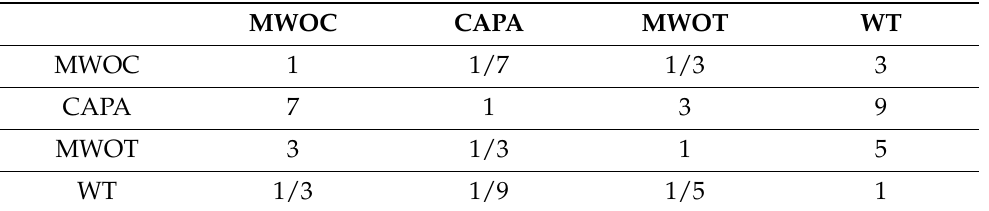
Table 7. Prioritization criteria pairwise comparison